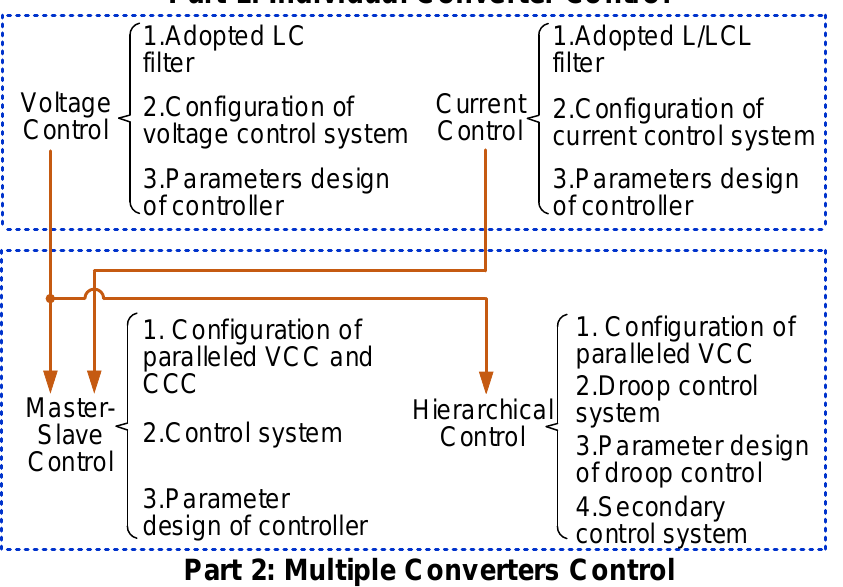
Figure 1. The knowledge coverage of testing and teaching for microgrid controls. VCC: voltage- controlled converter, CCC: current-controlled converter.